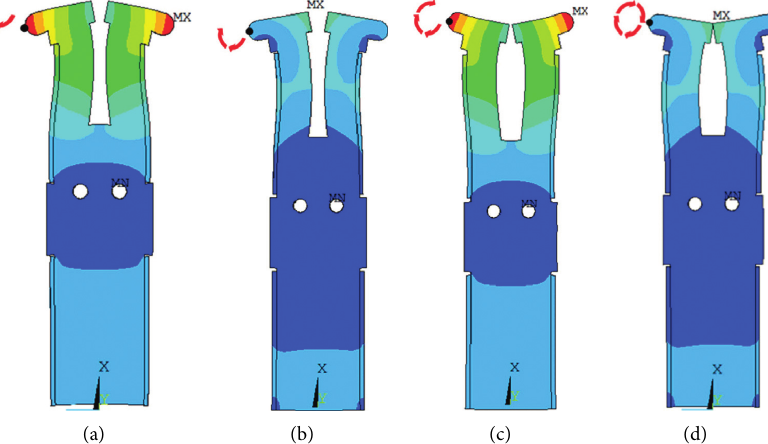
Figure 4: Combination process of stator elliptic motion. (a) t � T /4. (b) t � T /2. (c) t � 3 T /4. (d) t � T .